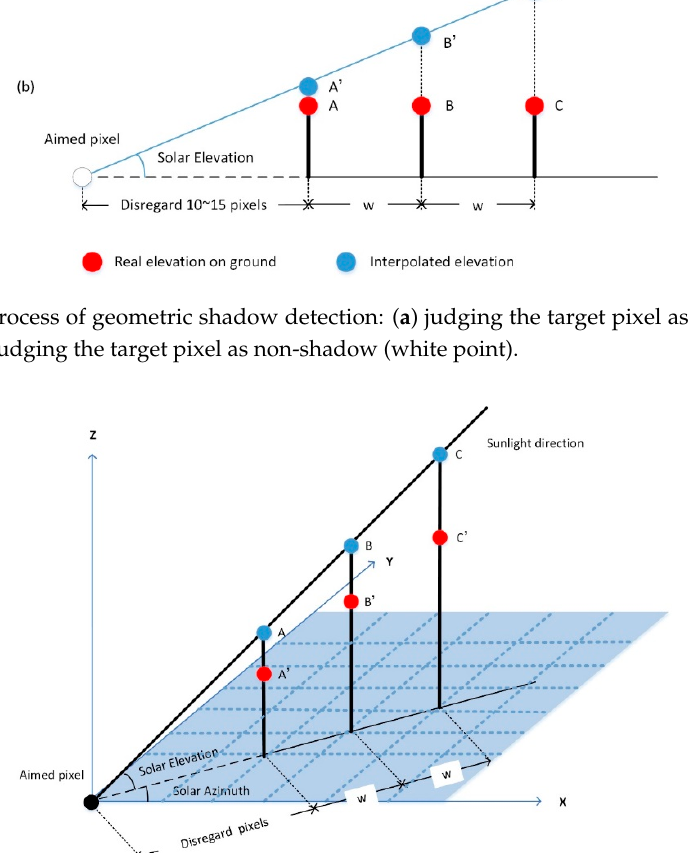
Figure 3. The process of geometric shadow detection in a three-dimensional view.